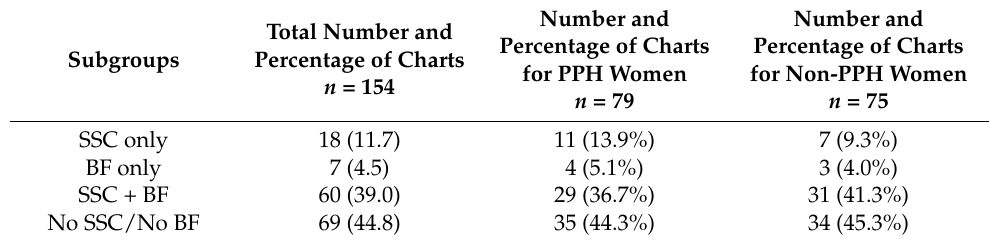
Table 1. Number of Charts Reviewed for Each Subgroup of the Total Sample. Number and Number and Total Number and Percentage of Charts Percentage of Charts Subgroups Percentage of Charts for PPH Women for Non-PPH Women n = 154 n = 79 n =